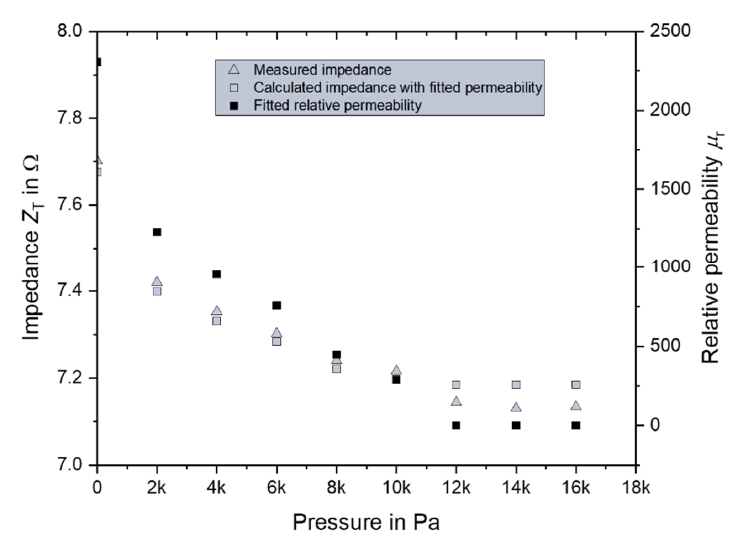
Figure 10. Relative permeability of the FeSiB film (right y -axis) obtained by fitting and a comparison of the measured impedance with that calculated with the obtained permeability.